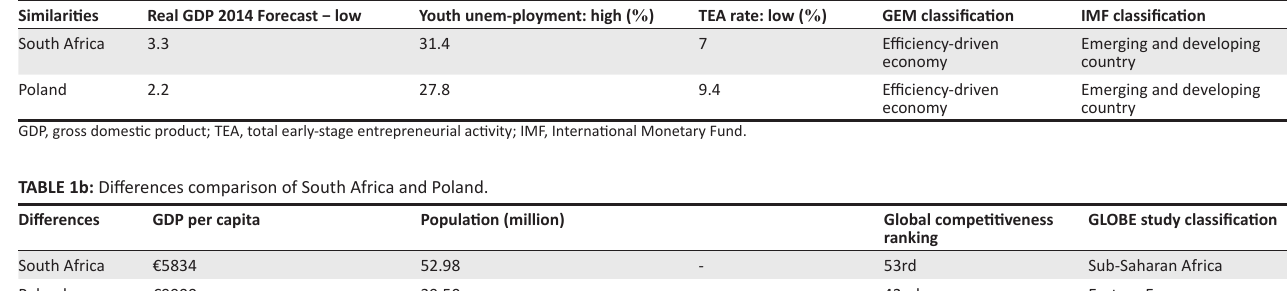
TABLE 1a: Similarities comparison of South Africa and Poland. Similarities